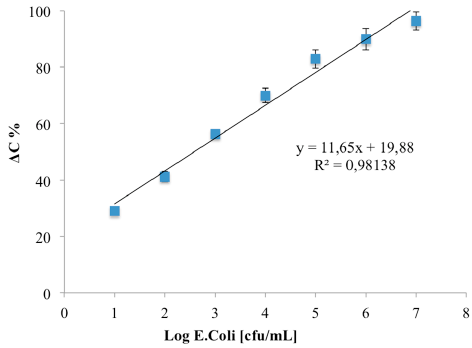
Figure 7. Calibration curve of Escherichia coli O157:H7 immunosensor. Data represent the average values of five immunosensors.